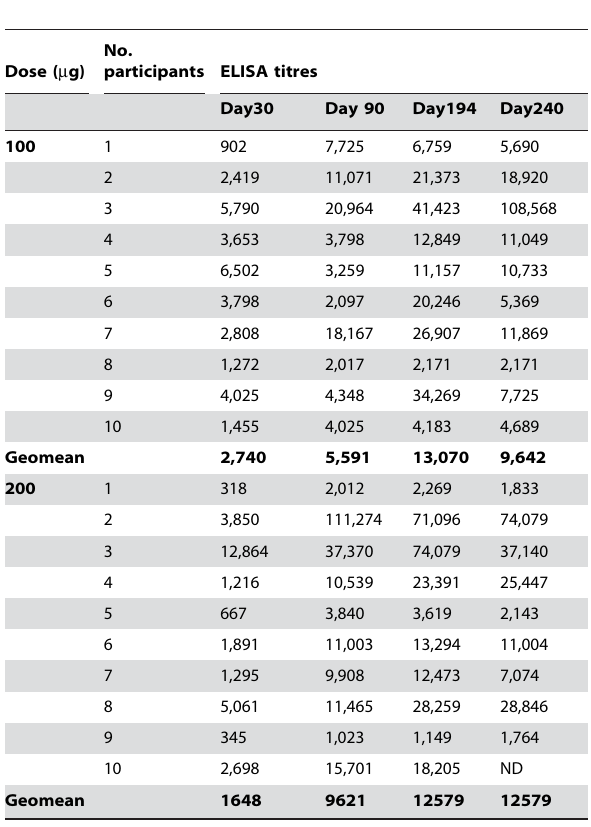
Table 6. ELISA antibody titer in time-point serum samples from participants in 100 and 200 m g